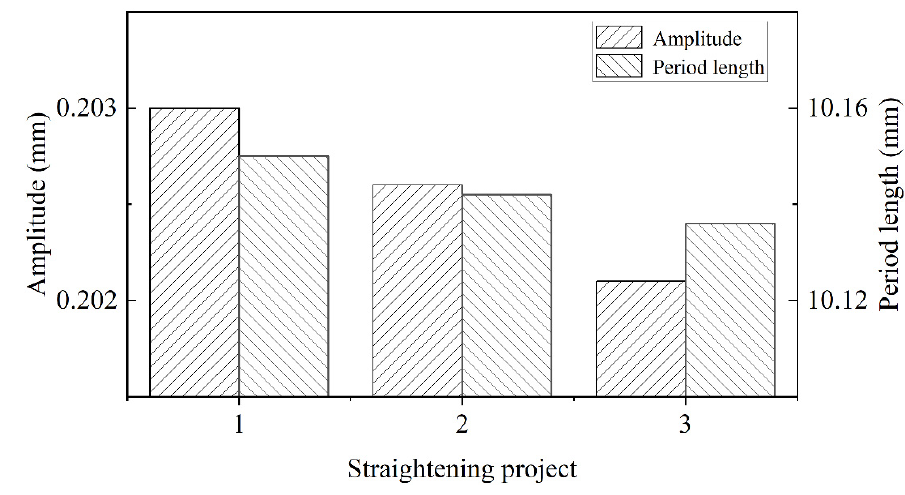
Figure 14. The morphology curve with different straightening projects.